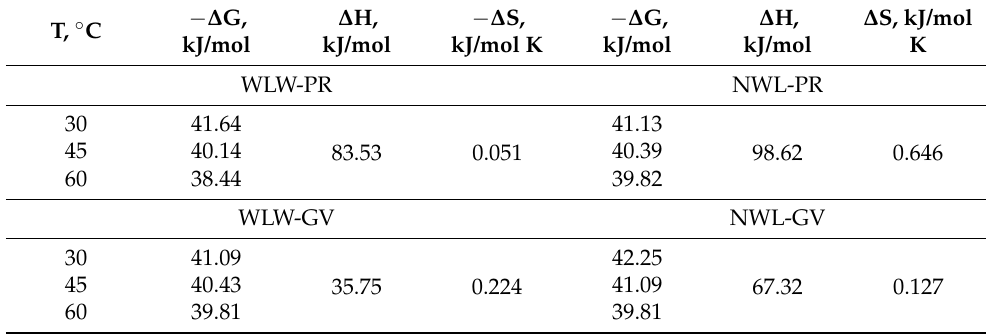
Table 4. Thermodynamic parameters of dye adsorption using modified